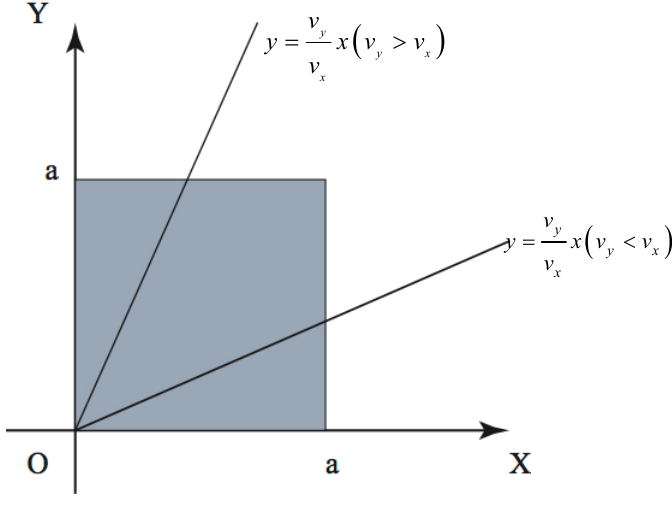
v y x v x Figure 2. The line y = divides the square cross-section into two parts, where the expression will be y v x y  divides the squarecross ‐ section into two parts, where the expression will Figure 2. The line di ff erent when the slope is > 1 or < v x be different when the slope is >1 or <1.